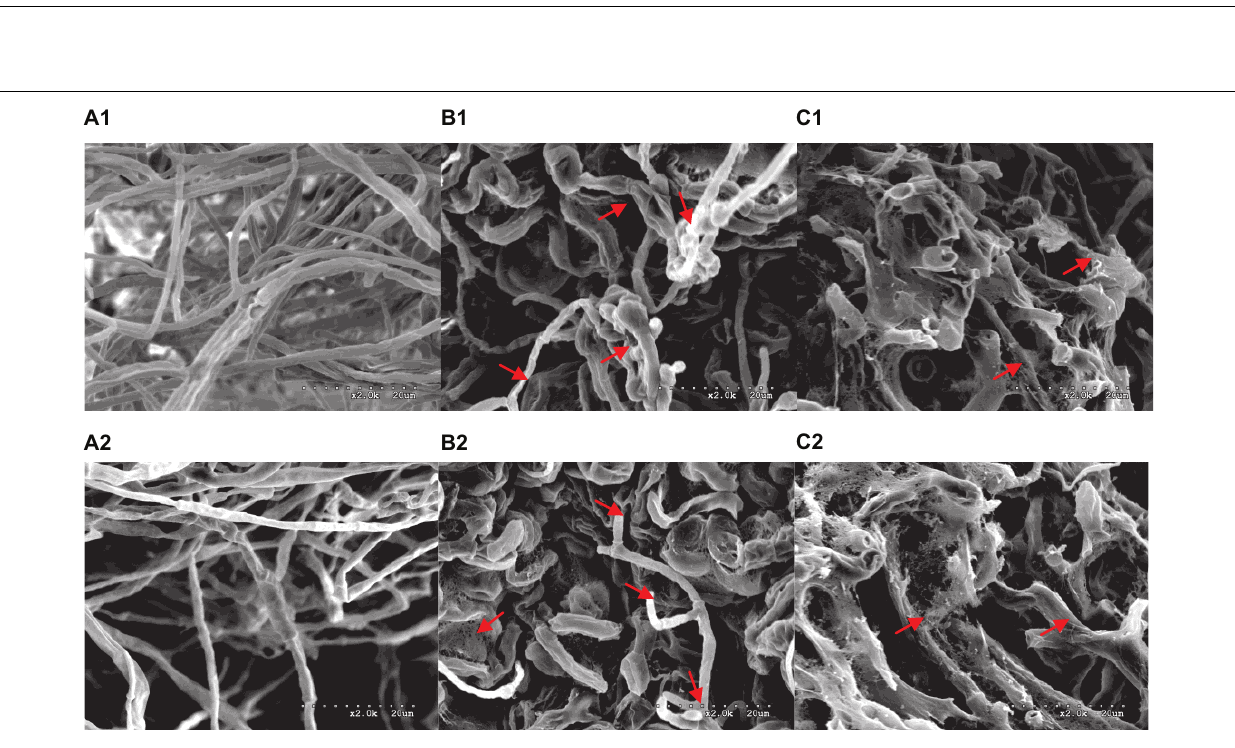
Frontiers in Microbiology |